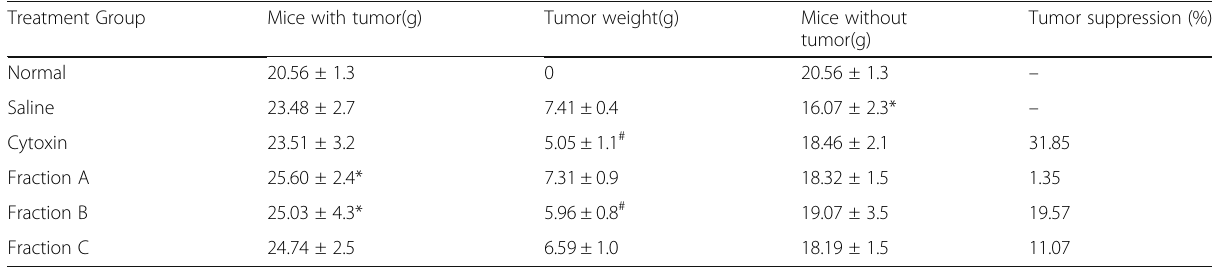
Table 1 Effect of licorice polysaccharides on weight of mice and tumor suppression Treatment Group Mice with